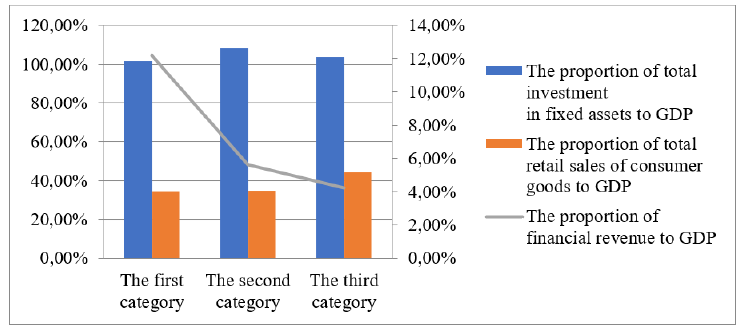
Fig. 4 A comparison of investment and consumption in counties across the three categories.